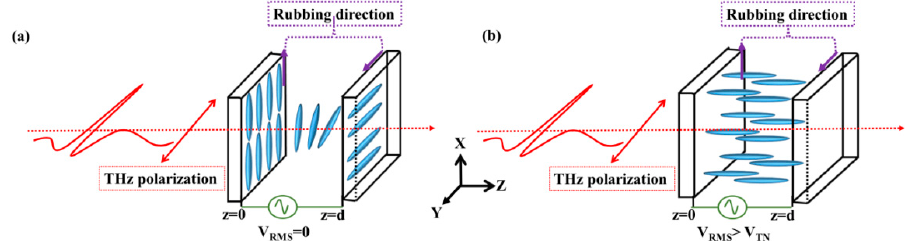
Figure 2. Schematic illustration of the operational principles of a TN-LC THz phase shifter for ( a ) V RMS = 0 and ( b ) V RMS > V TN .